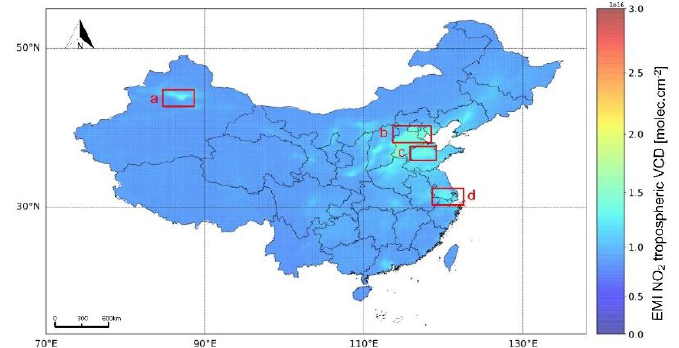
Figure 3. The distribution of tropospheric NO 2 vertical columns in Mainland China from November 2018 to April 2019, from November 2018 to April 2019. ( a ) Urumqi, ( b ) Beijing–Tianjin–Hebei (BTH), ( c ) central Shandong, ( d ) Yangtze River Delta.